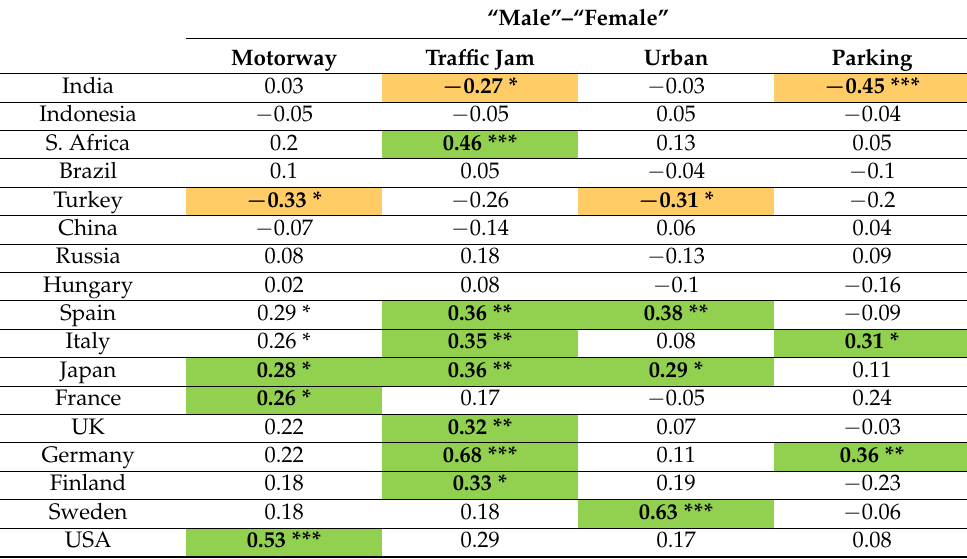
Table 9. Differences in the mean intention to use scores for males vs. females across the 17 countries (ordered from lowest to highest GDP; [33]). A positive number highlighted green indicates that males had a significantly higher intention to use score than females. A negative number highlighted orange indicates that females had a significantly higher intention to use score than males.